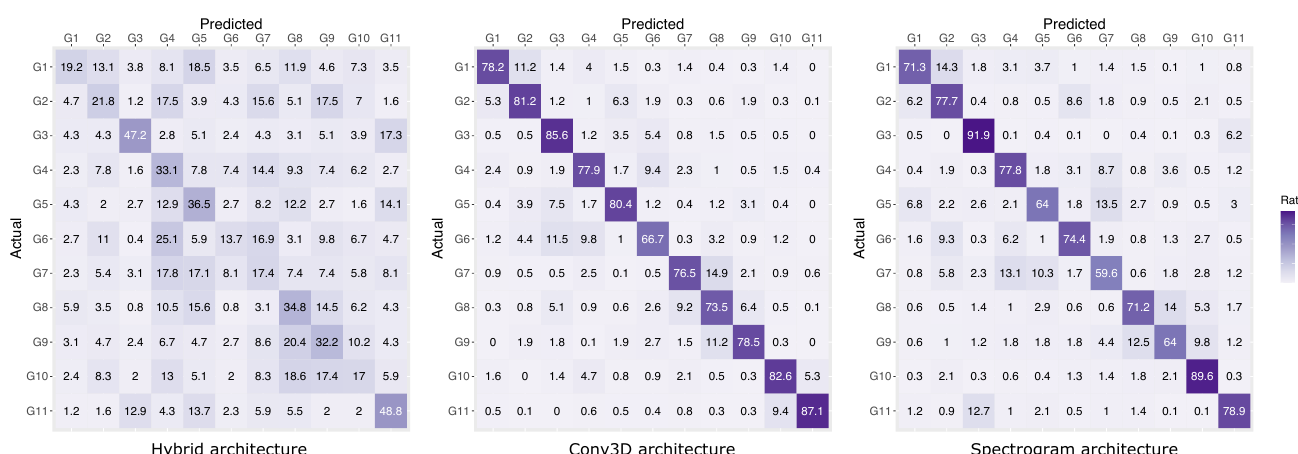
Figure 10. Confusion matrix for the full gesture set (11 gestures).